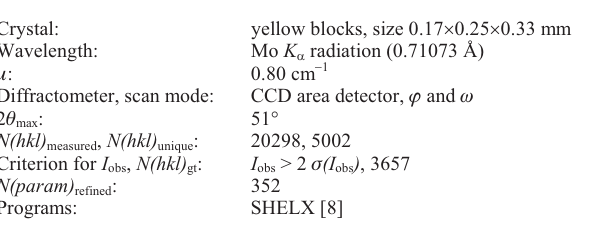
Table 1. Data collection and handling.